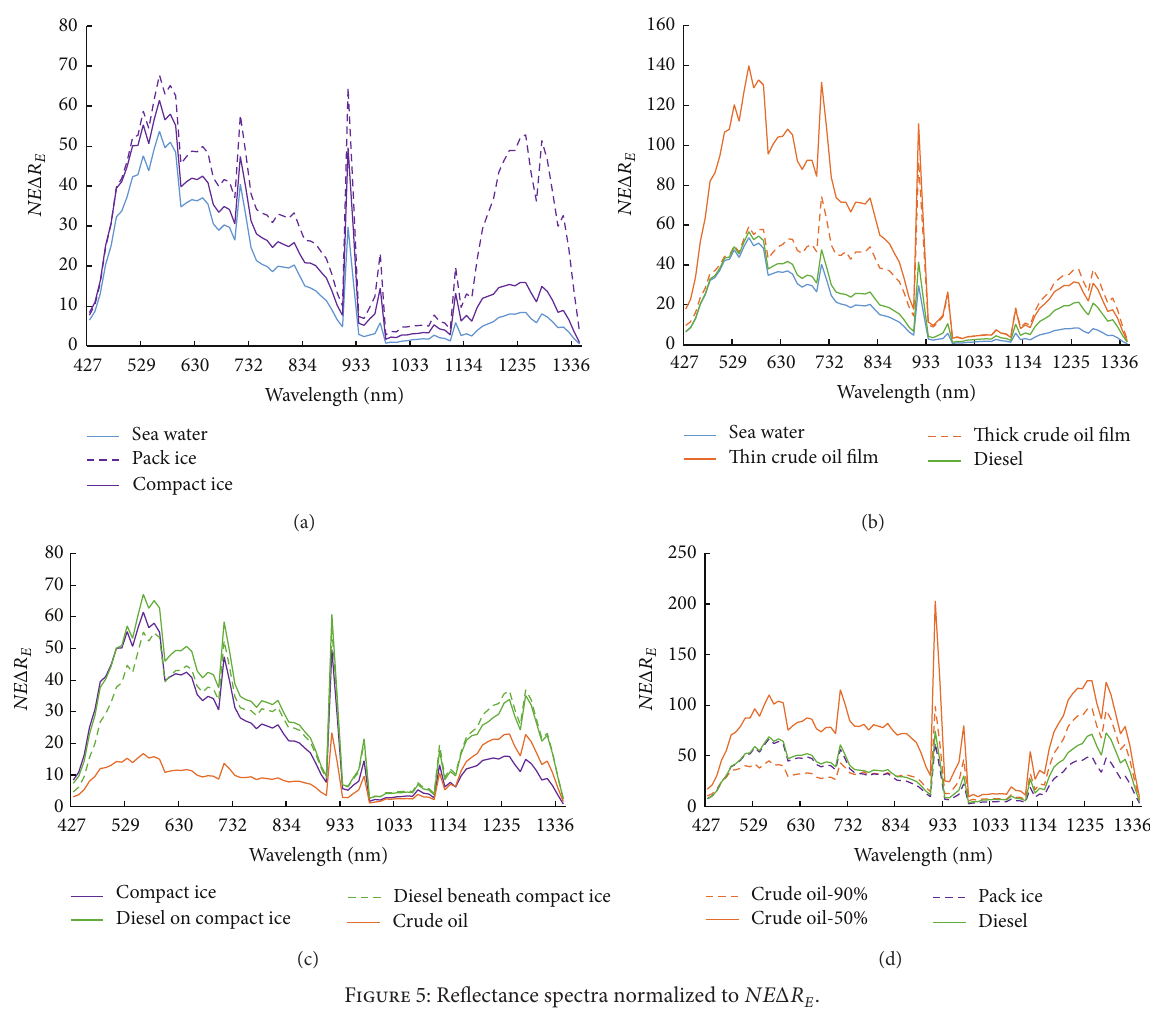
Figure 5: Reflectance spectra normalized to 𝑁𝐸Δ𝑅 𝐸